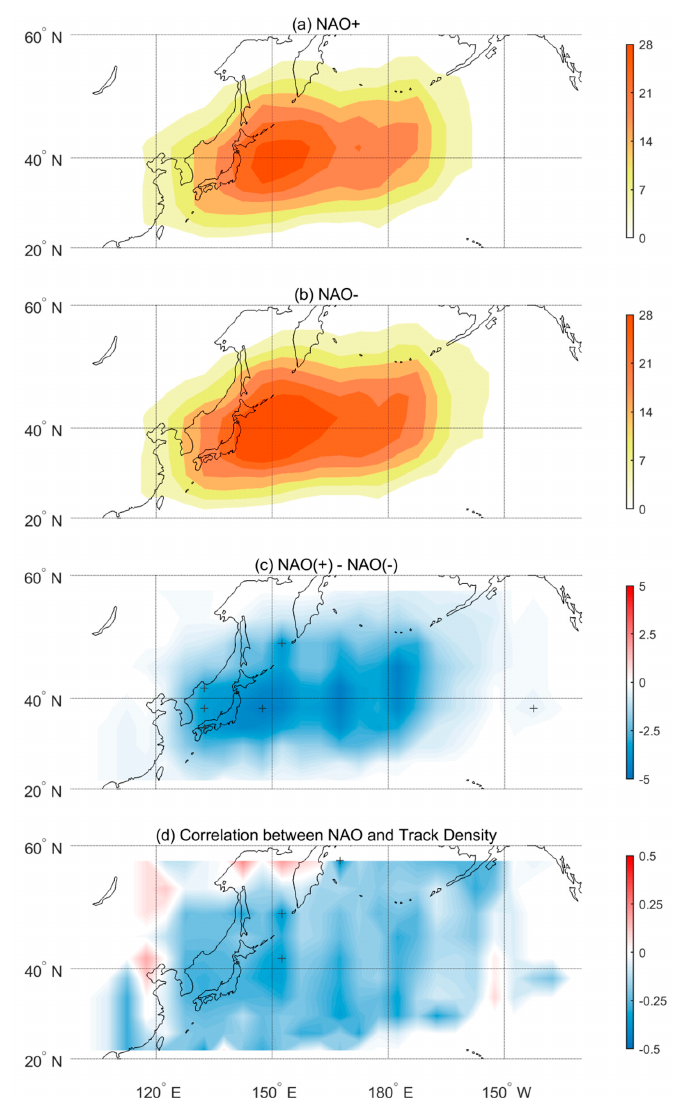
Figure 6. ( a , b ) Composite of the ETC track density in the positive and negative phases of NAO over the Northwest Pacific in wintertime from 1979 to 2018, Unit: cyclones per winter per grid. ( c ) The difference in ETC density between the positive and negative phases of NAO. ( d ) Correlations between the NAO index and ETC track density. Grids with values statistically significant at the 95% level are indicated by the symbol “+”.